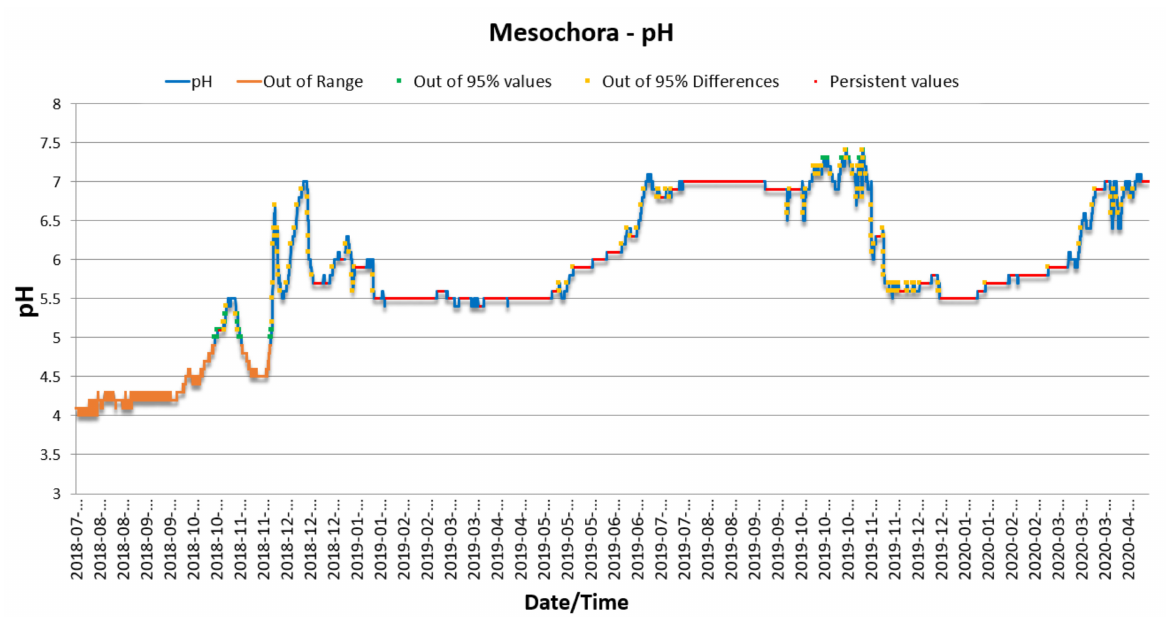
Figure 3. Change of water pH (blue line) on an hourly basis at Mesochora station and marking of values, which are out of the allowable range (orange color), outside the 2.5% and 97.5% percentiles of observations (green color), outside the 2.5% and 97.5% percentiles of absolute differences of consecutive observations (yellow color) and unchangeable for more than two days of continuous recording (red